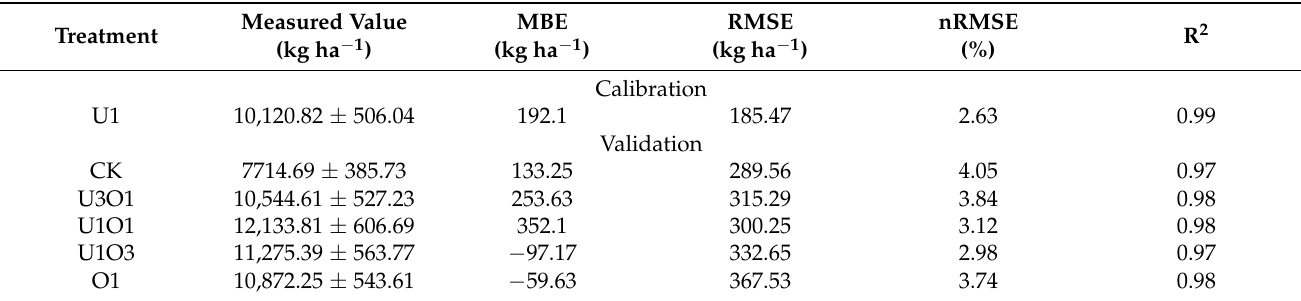
Table 3. Statistical evaluation of the model simulation of grain yield from different treatments